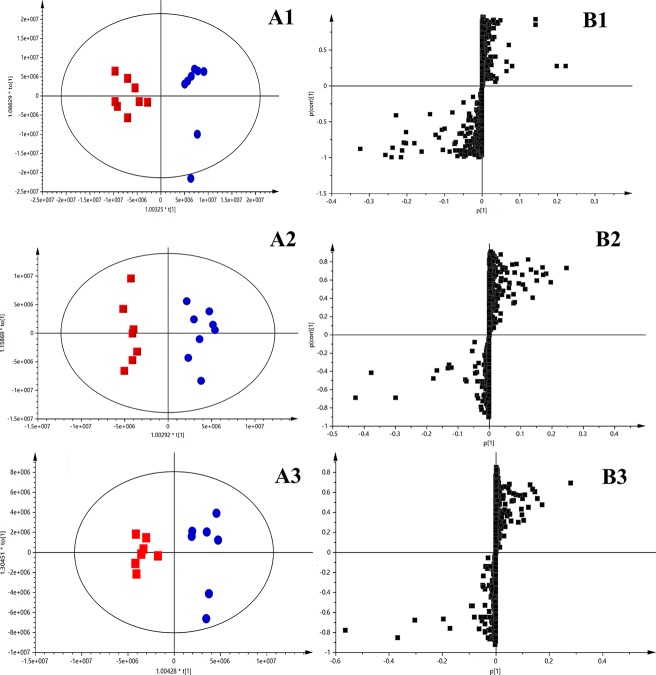
OPLS-DA results between the sham group and model group based on the merged data of plasma untargeted metabolic profiles. (A) OPLS-DA scores plot, sham group (blue) vs. model group (red); (A1), 2nd week after occlusion; (A2), 4th week after occlusion; (A3), 10th week after occlusion; (B) S-plot constructed from OPLS-DA; (B1), 2nd week; (B2), 4th week; (B3), 10th week. The ions (black square) furthest away from the origin contribute significantly to be responsible for the separation between sham and model group.